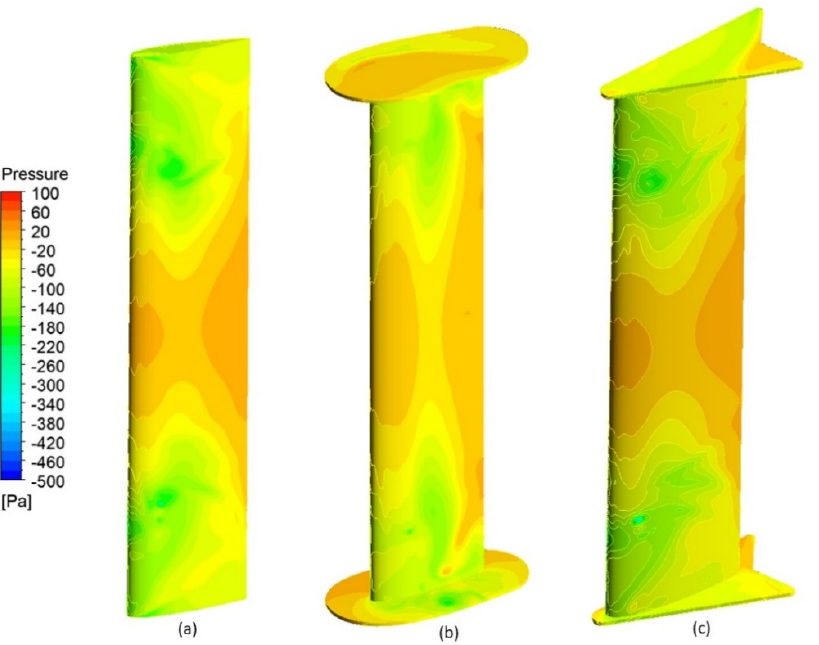
Table 4. Cycle-averaged C P at 0.015625H in TSRs 1 and 2.